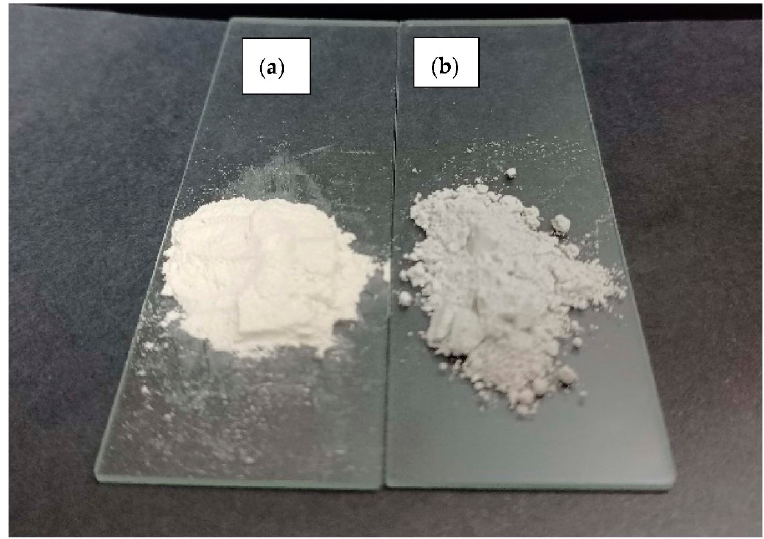
Figure 7. Photos of ( a ) raw dolomite (RD) and ( b ) dolomite nanoparticles (DNPs).